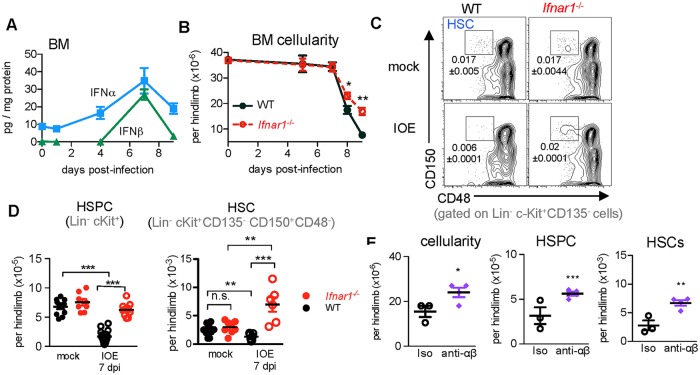
HSC and HSPC depletion in IOE infection is type I IFN-dependent.(A) BM IFNα and IFNβ levels at indicated days post-infection (d.p.i.) of wildtype (WT) mice. n = 4–10 mice/group. (B) BM cellularity of infected WT and Ifnar1-/- mice. n = 4–14 mice/group, P < 0.05 for Ifnar1-/- vs. WT by 2-way ANOVA. Significant differences were observed between strains on days 8 and 9 post-infection. (C) Representative flow cytometric plots of CD150 and CD48 expression among Lin- cKit+ CD135- BM cells from mock and IOE infected WT and Ifnar1-/- mice. Gated population represents phenotypic HSCs, and numbers indicate absolute frequencies of HSCs. (D) Numbers of HSPCs (Lin- cKit) and HSCs (Lin- cKit+ CD135- CD150+ CD48-) in WT and Ifnar1-/- mice, n = 5–10 mice/group, **P < 0.01, ***P < 0.001 (E) BM cellularity, HSPCs, and HSCs in isotype- or anti-αβ–treated mice in IOE infected mice at 8 d.p.i. n = 3–4 mice/group.